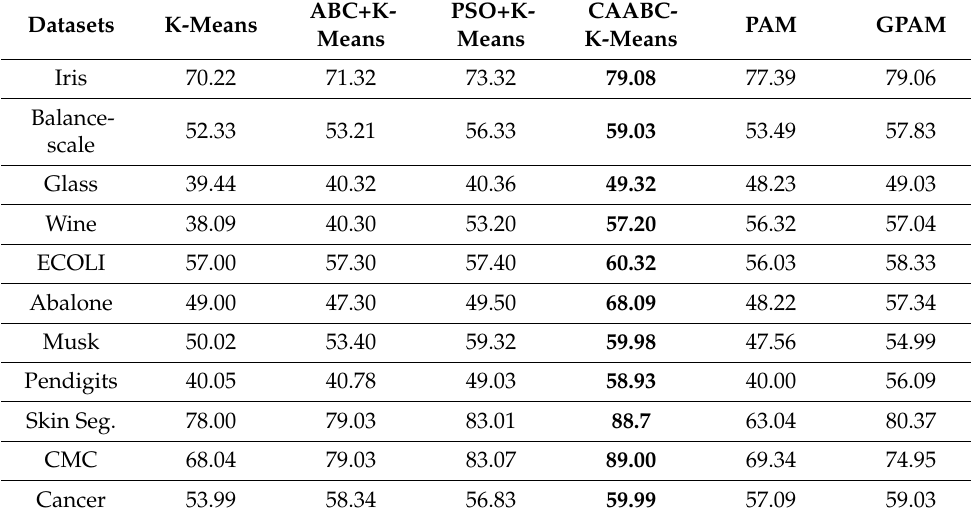
Table 6. The Normalized Mutual Information for classifying the eleven training datasets.